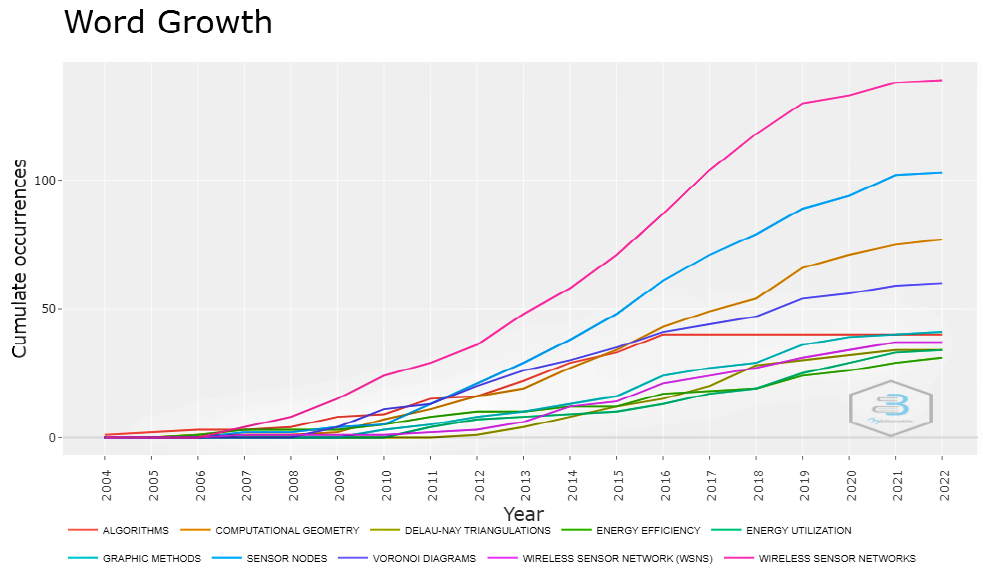
Figure 4. Word growth over time during the period 2004–2022.